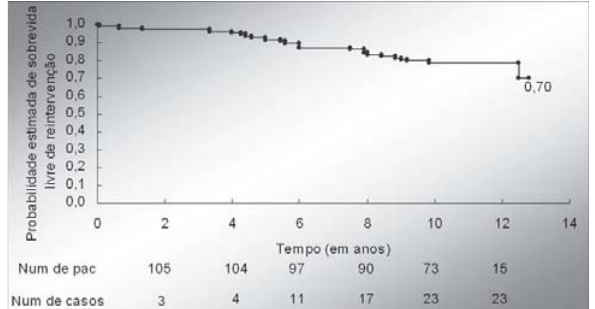
Fig. 3 – Probabilidade estimada de sobrevida livre de reintervenção